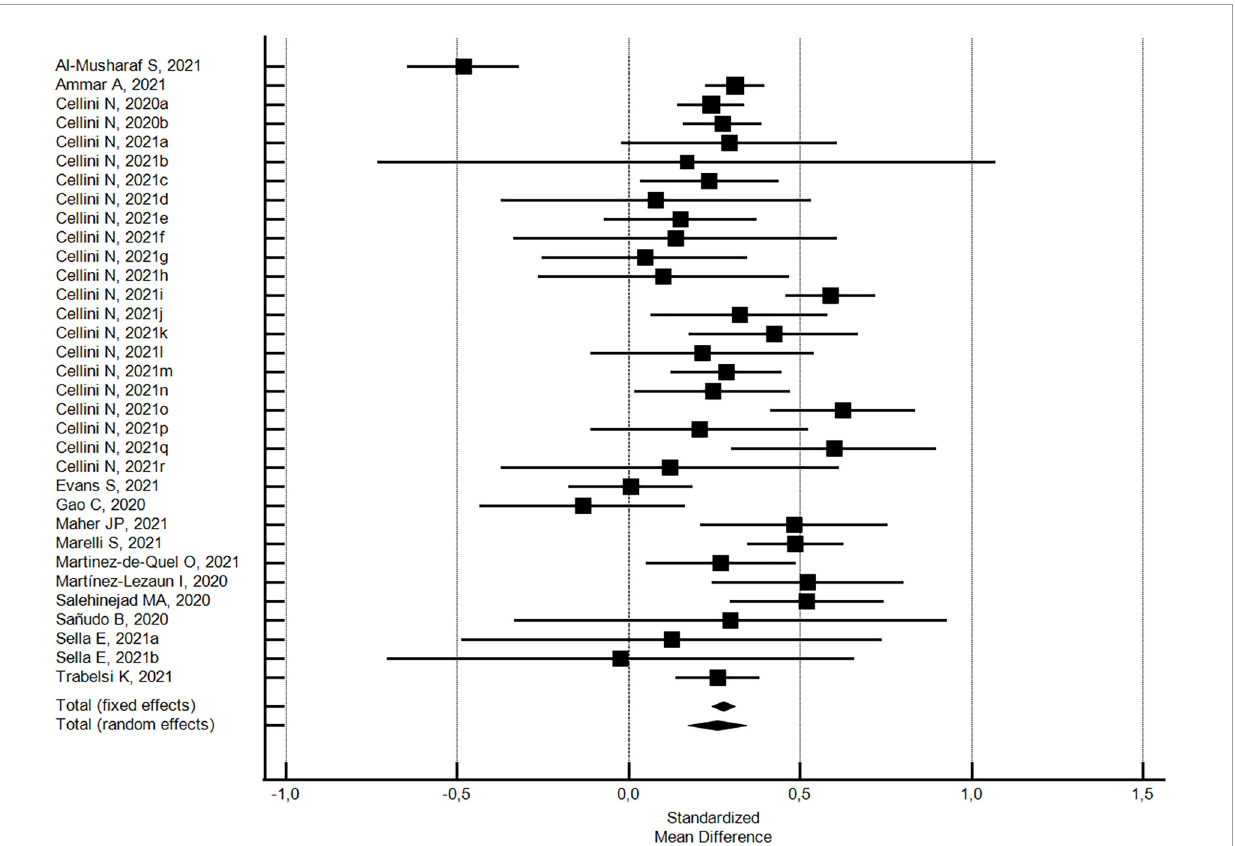
FIGURE2 Forest plot showing pooled changes in sleep quality PSQI global score from before to during the COVID-19 lockdown. Cellini N, 2020a: Student; Cellini N, 2020b: Worker; Cellini N, 2021a: Belgian Students, Female; Cellini N, 2021b: Belgian Students, Male; Cellini N, 2021c: Belgian Regular workers, Female; Cellini N, 2021d: Belgian Regular workers, Male; Cellini N, 2021e: Belgian Remote workers, Female; Cellini N, 2021f: Belgian Remote workers, Male; Cellini N, 2021g: Belgian Unemployed/retired, Female; Cellini N, 2021h: Belgian Unemployed/retired, Male; Cellini N, 2021i: Italian Students, Female; Cellini N, 2021j: Italian Students, Male; Cellini N, 2021k: Italian Regular workers, Female; Cellini N, 2021l: Italian Regular workers, Male; Cellini N, 2021m: Italian Remote workers, Female; Cellini N, 2021n: Italian Remote workers, Male; Cellini N, 2021o:Italian Stop working, Female; Cellini N, 2021p: Italian Stop working, Male; Cellini N, 2021q: Italian Unemployed/retired, Female; Cellini N, 2021r: Italian Unemployed/retired, Male; Sella E, 2021a: Older; Sella E, 2021b: Young. Error bars = 95% confidence interval; Square boxes = individual study point estimates; and Diamond box = Pooled point